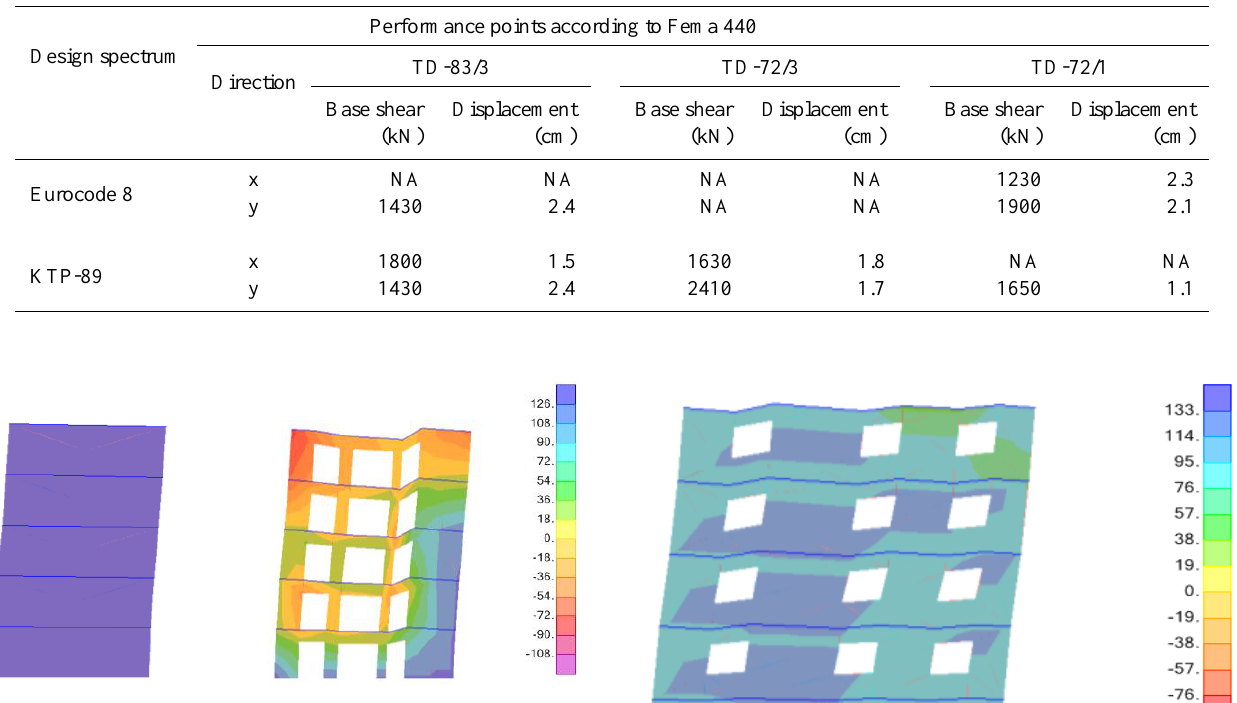
Table 4. Performance points according to Fema 440 for the considered buildings under both spectrums.